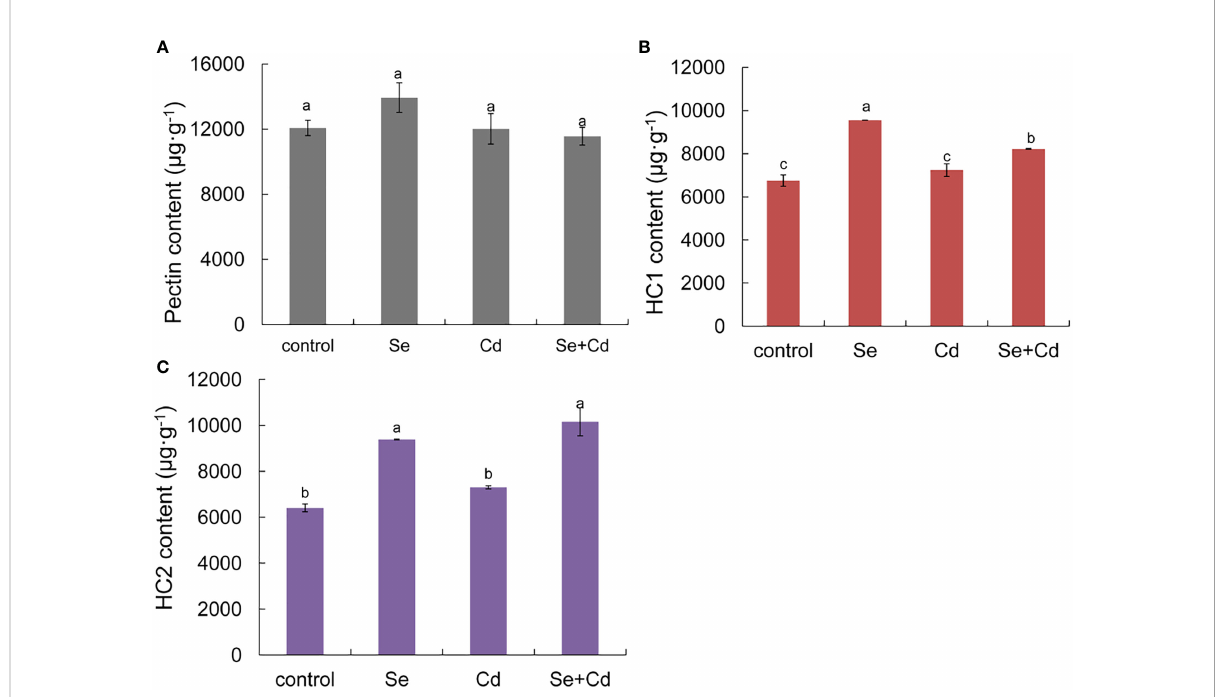
FIGURE 2 Effects of root exposure of Se (1.2 mg/kg) on root cell wall components of perilla under Cd stress (10 mg/kg). (A) pectin content; (B) hemicellulosic 1 (C) hemicellulosic 2. The different letters indicate signi fi cantly different values (P < 0.05 according to Duncan ’ s